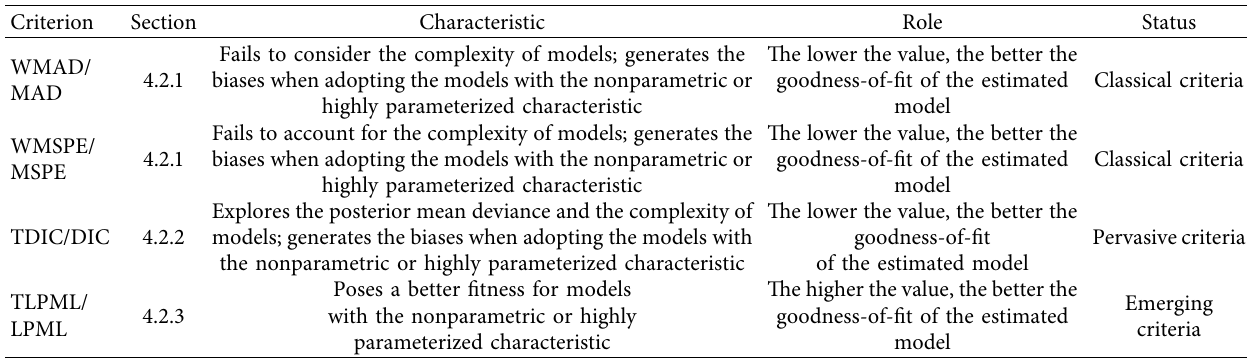
Table 3: The summary of comparison criterion in the